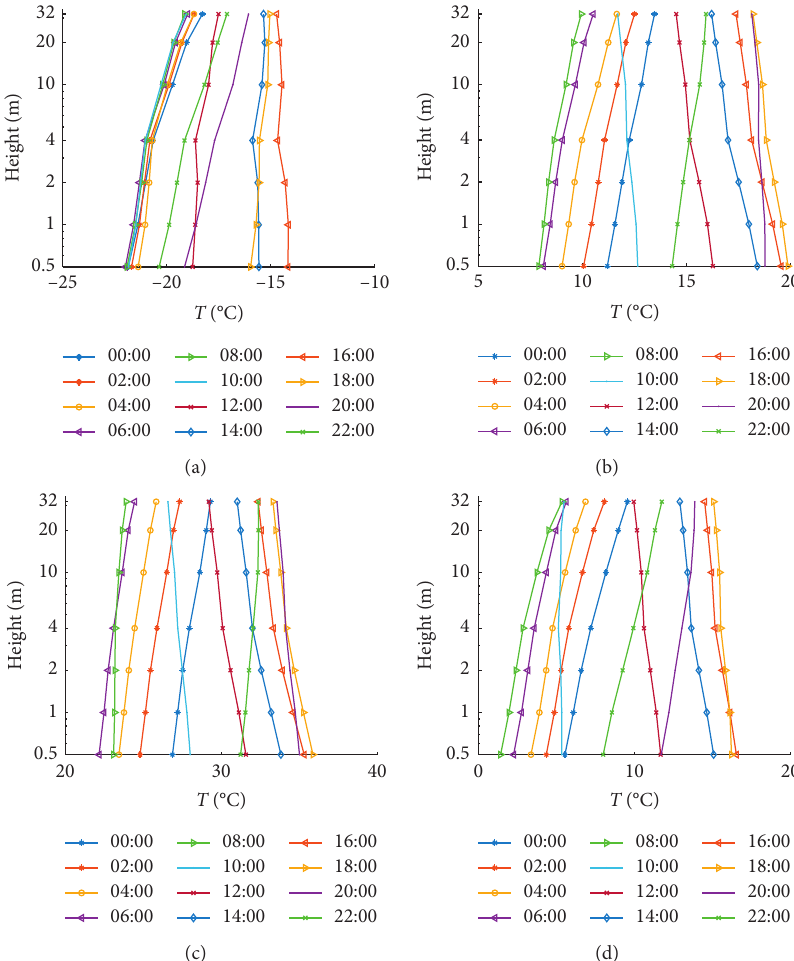
Figure 4: Temperature profiles on typical sunny day under the four underlying surface conditions of the Gurbant¨ungg¨ut Desert. (a) Winter. (b) Spring. (c) Summer. (d)